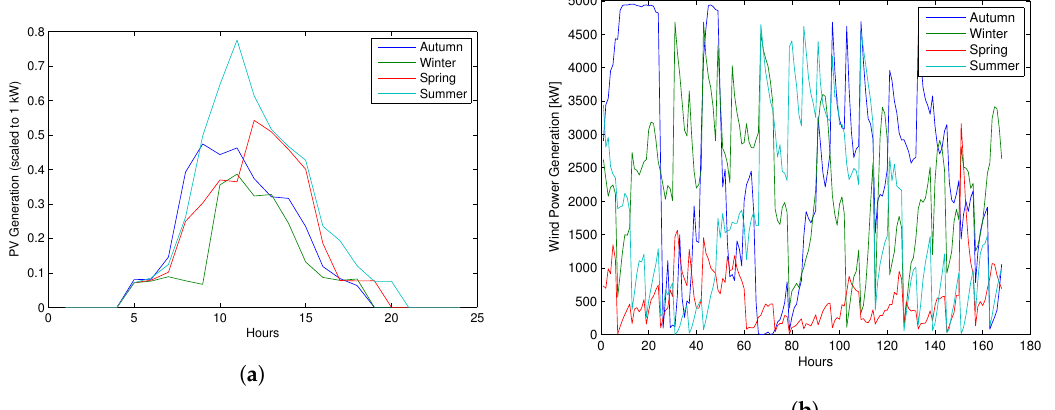
Figure 4. Four RES generation profiles: (i) Autumn, (ii) Winter, (iii) Spring, (iv) Summer. ( a ) PV generation on representative days; ( b ) Wind power generation on representative